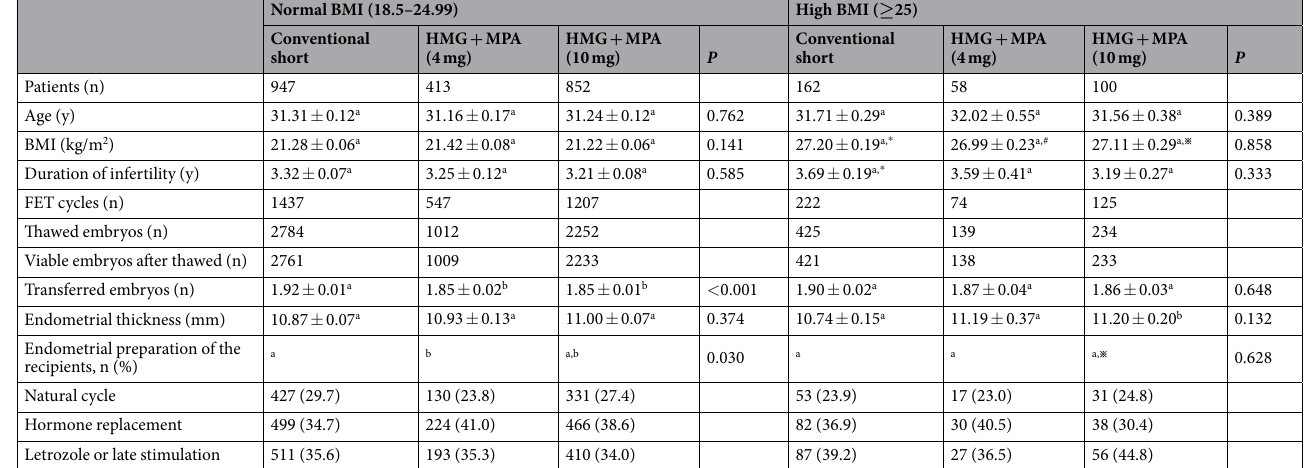
Table 3. Women and cycle’s characteristics of frozen-thawed embryos originating from three ovarian stimulation groups according to female BMIs. One-way ANOVA analysis, the nonparametric test, student’s t- tests or Mann-Whitney U -test were applied. Data are presented as mean ± standard error of the mean. The differences were considered statistically significant when the p- value was less than 0.05. When compared with the p -value of subgroups in the same BMI group, the different superscript alphabets of a, b, c stand for a significant difference ( p < 0.05). When compared with the p -value of the normal BMI group and high BMI group in the same ovary stimulation group, the symbols * , # , ※ separately stands for a significant difference ( p < 0.05) in the conventional short, HMG + MPA (4 mg) and HMG + MPA (10 mg) ovary stimulation